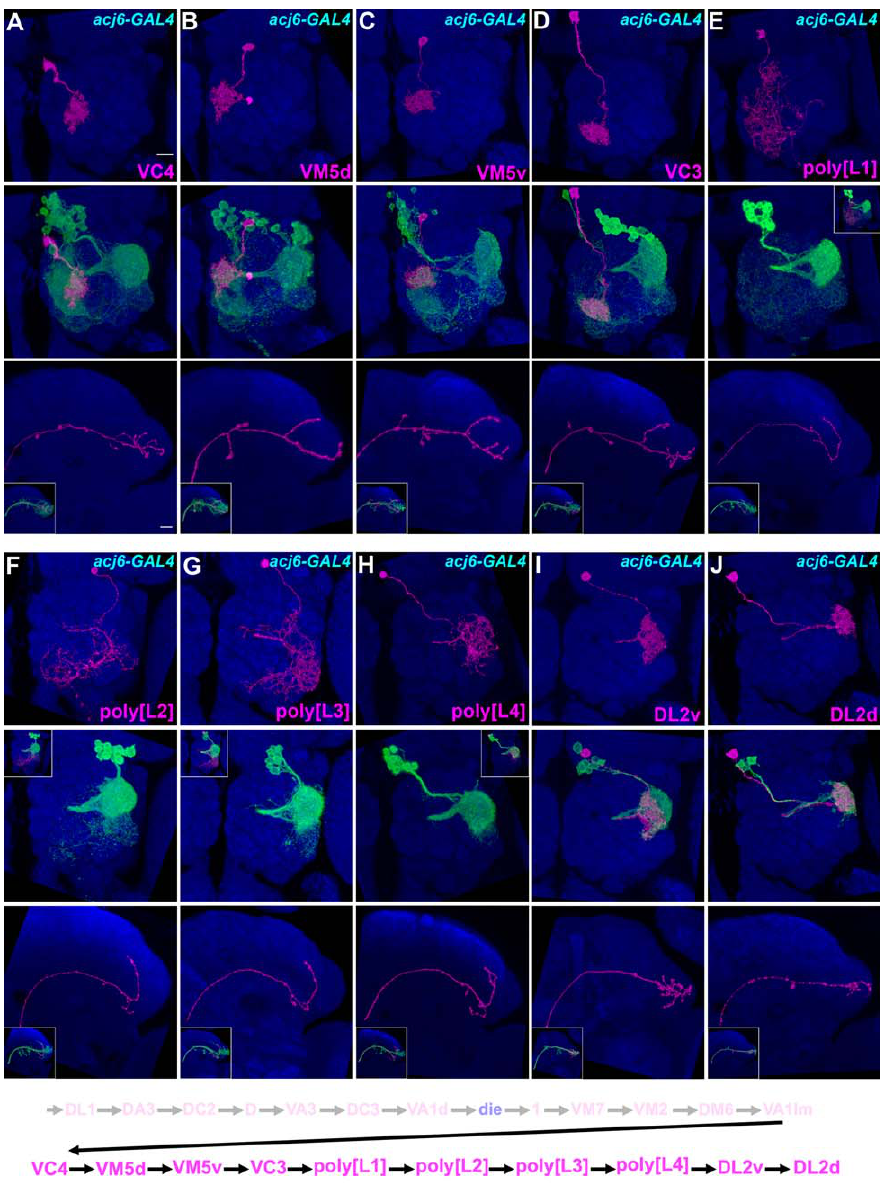
Figure 3. Ten types of late-larval-derived Acj6-positive adPNs. Late-larval-derived twin-spot clones labeled with acj6-GAL4 . Top and middle panels: composite confocal images of the AL showing single adPNs only or both single adPNs (magenta) and their paired NB clones (green); bottom panels: the axon projections of single adPNs and in islets the projections of single adPNs (magenta) and their accompanying NB clones (green). Analysis of NB clones paired with distinct adPNs revealed 10 additional adPN types are made in an invariant sequence as summarized in the bottom. Note presence of four types of polyglomerular PNs that exhibit different patterns of AL elaboration while acquiring analogous axon projections in the LH